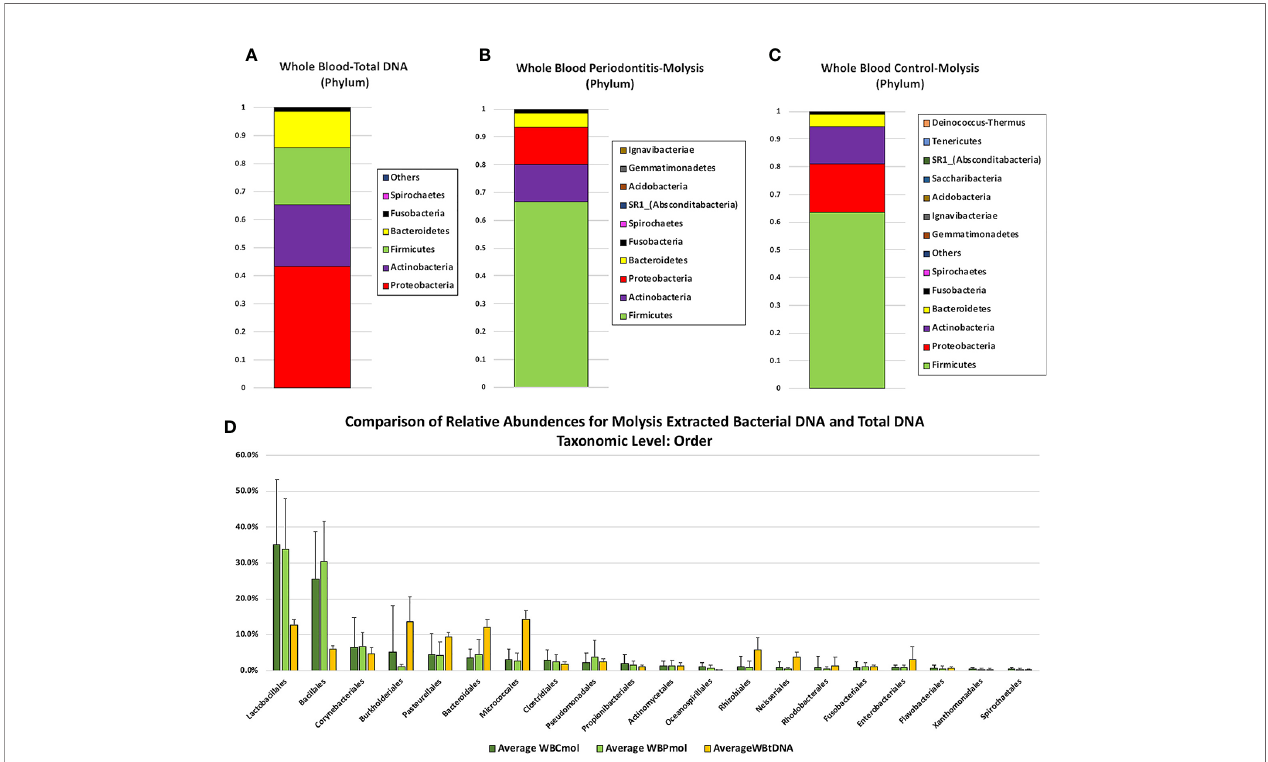
FIGURE 1 | Comparison of phylum level relative abundance pro fi les from (A) total DNA samples extracted from whole blood by PCI (n = 4), (B) Molysis-extracted DNA from whole blood from control patients (WBC) (n = 19), and (C) Molysis-extracted DNA from blood from patients with periodontitis (WBP) (n = 17).The OTU representing 3 members of the Streptococcus mitis group is designated SMG-subgroup. Panel 1 (D) compares average percentage composition pro fi les for total DNA samples versus MolYsis-extracted samples at the Order